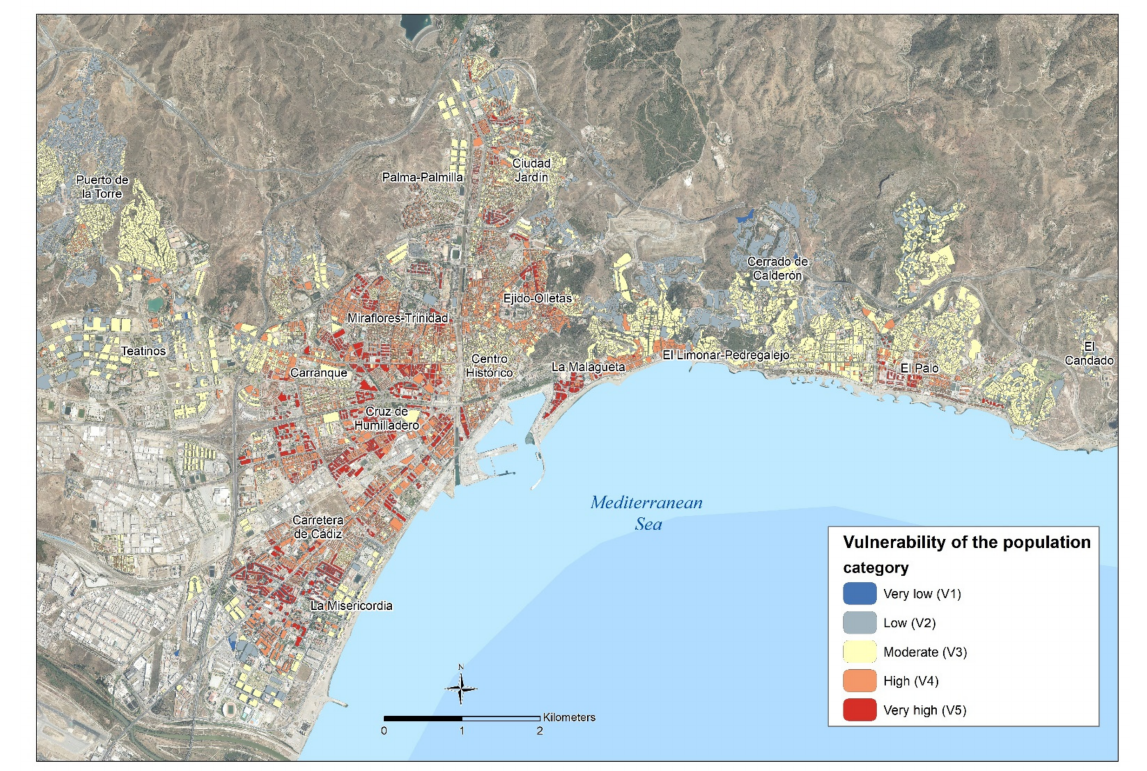
Figure 11. Map of the vulnerability of the exposed population. Own elaboration.